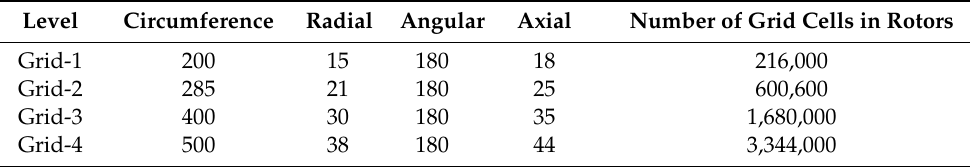
Table 4. Grid levels and number